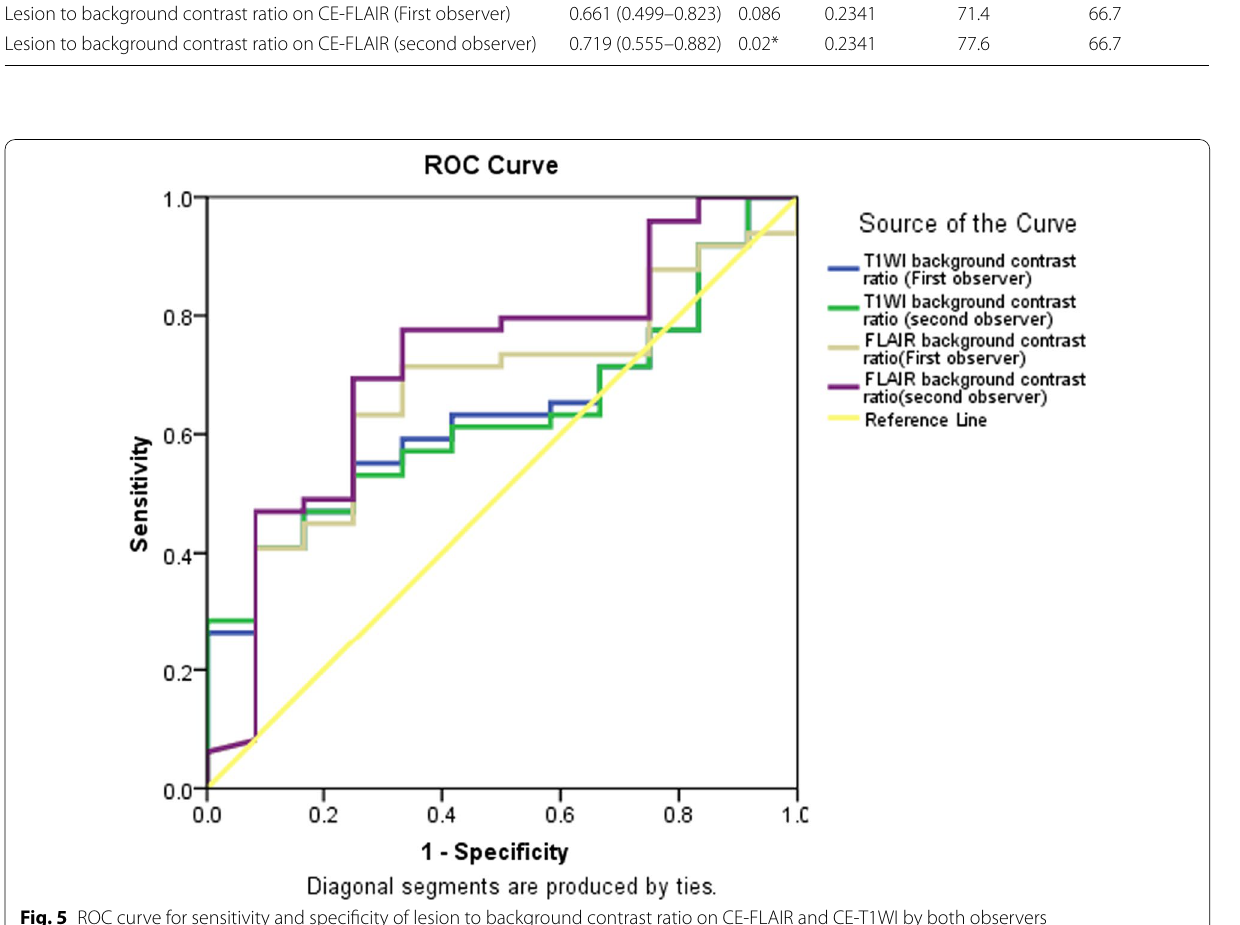
Fig. 5 ROC curve for sensitivity and specificity of lesion to background contrast ratio on CE‑FLAIR and CE‑T1WI by both